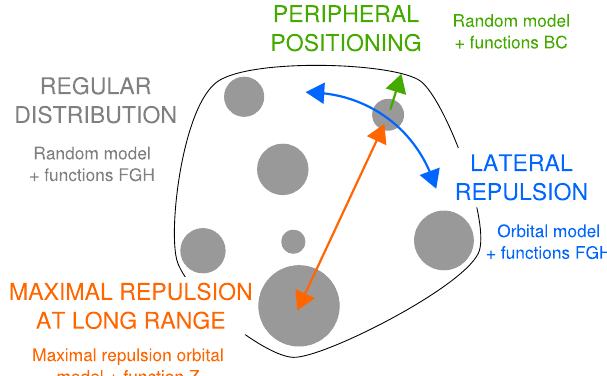
Figure 7. Schematic summary of elements involved in the 3D organization of heterochromatin. The three spatial models (random model, orbital model and maximal repulsion orbital model), combined with functions B , C , F , G , H and Z , unraveled new properties of Arabidopsis chromocenter distribution. A complex, multiscale and multiaxis organization of chromocenters was revealed using the proposed